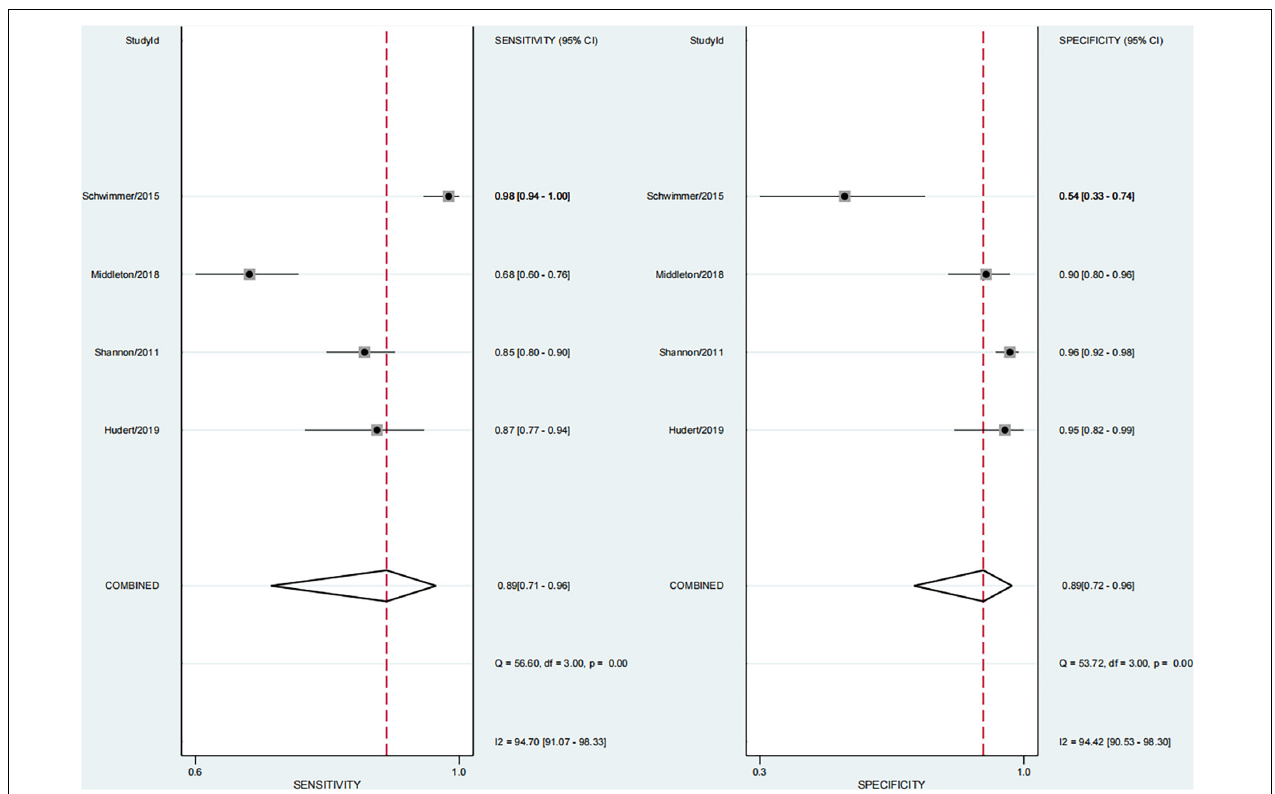
FIGURE 11 | Sensitivity and specificity of imaging techniques for the diagnosis of